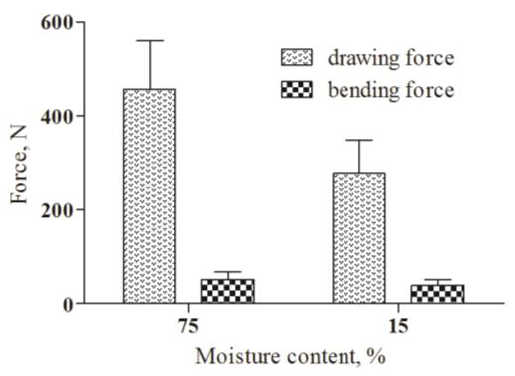
Figure 5. Result analysis of mechanical testing.